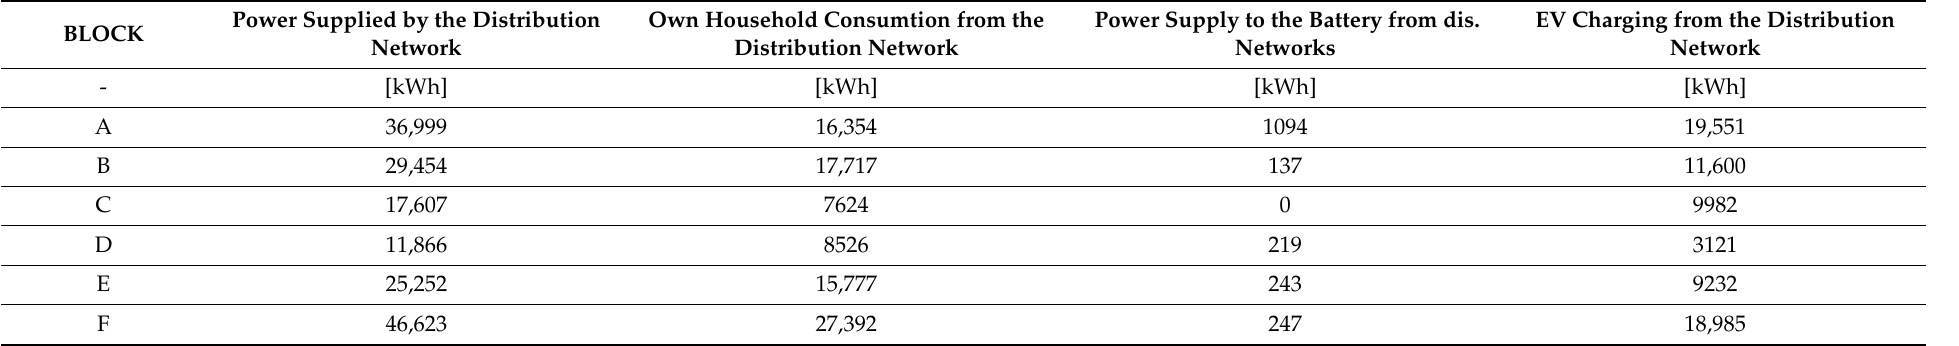
Table 21. Own household